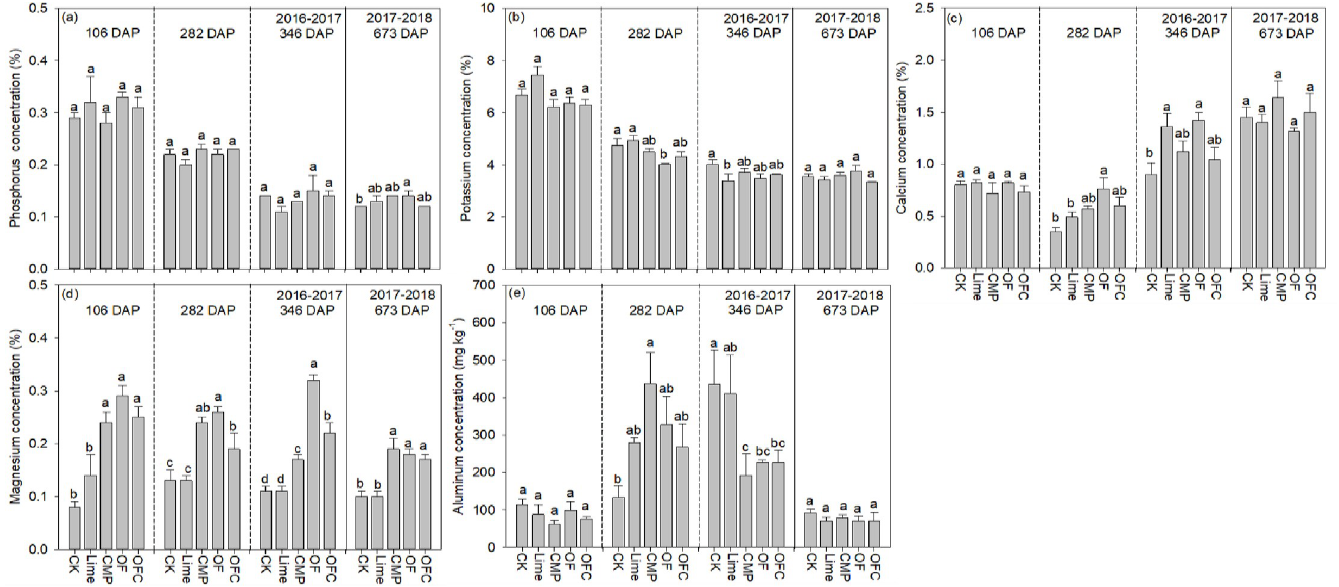
Fig 3. Effect of different soil amendments treatments on nutrient concentrations in banana leaves. The plants were grown in soil amended with lime (Lime), calcium magnesium phosphate fertilizer (CMP), organic fertilizer (OF), organic fertilizer with calcium magnesium phosphate fertilizer (OFC) or remained unamended (CK). Values are means ± SE (n = 3). Different lowercase letters within each column denote significant differences among different treatments in 2016–2017 and 2017– 2018 ( P < 0.05). https://doi.org/10.1371/journal.pone.0230593.g003 with shoot biomass cross all sampling times, whilst significant correlations between leaf K or Ca concentration with shoot biomass were only observed at 282 days (Table 1). Leaf Mn con- centration was significantly negatively correlated with shoot biomass at 106 and 673 days. Leaf P, Fe, Cu and Zn concentrations were not significantly correlated with shoot biomass at either sampling time (S2 Table).